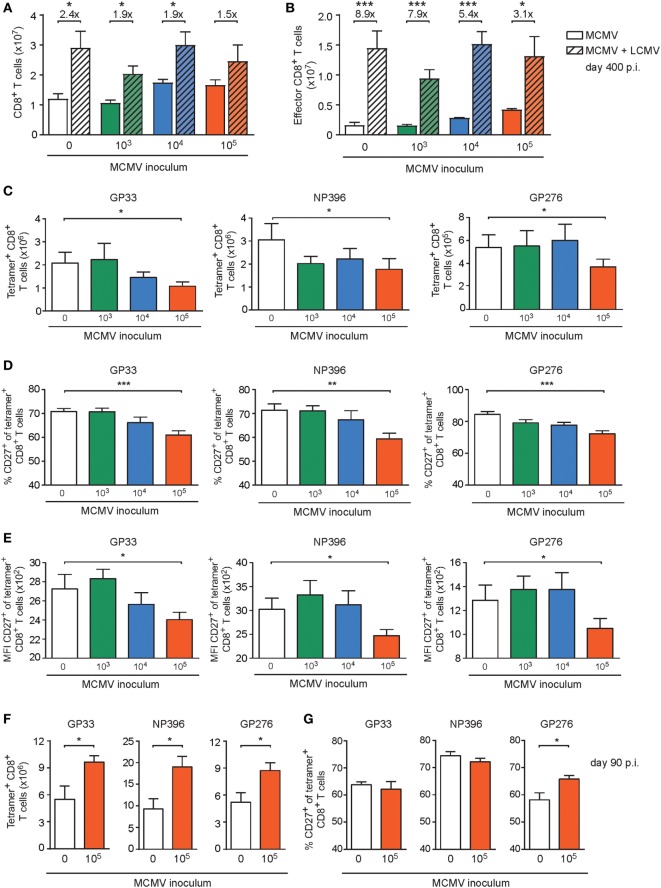
High-dose CMV infection impairs the development of heterologous viral-specific T cell responses. (A–E) Wild-type (WT) mice were kept uninfected or infected with 103, 104, or 105 PFU mouse CMV (MCMV)-Smith (n = 16 mice per group), and at day 400 post-infection 8 mice per group were challenged with 2 × 105 PFU lymphocytic choriomeningitis virus (LCMV)-Armstrong. At day 8 post LCMV infection, mice were analyzed and compared with uninfected littermate controls. (A) Numbers of total splenic CD8+ T cells. (B) Numbers of total effector (CD44highCD62L− KLRG1+) CD8+ T cells. (C) Numbers of splenic LCMV-specific CD8+ T cells determined by MHC class I tetramer staining. (D) Percentage of LCMV-specific CD8+ T cells expressing CD27. (E) Mean fluorescence intensity (MFI) of CD27 expression on LCMV-specific CD8+ T cells. (F,G) WT mice were kept uninfected or infected with or 105 PFU MCMV-Smith (n = 8 mice per group), and at day 90 post-infection challenged with 2 × 105 PFU LCMV-Armstrong. At day 8 post LCMV infection, mice were analyzed and compared with uninfected littermate controls. (F) Numbers of splenic LCMV-specific CD8+ T cells determined by MHC class I tetramer staining. (G) Percentage of LCMV-specific CD8+ T cells expressing CD27. Results are represented as means and error bars indicate SEM (n = 8 mice per group). *P < 0.05; **P < 0.01; ***P < 0.001. Data were pooled from two independent experiments.